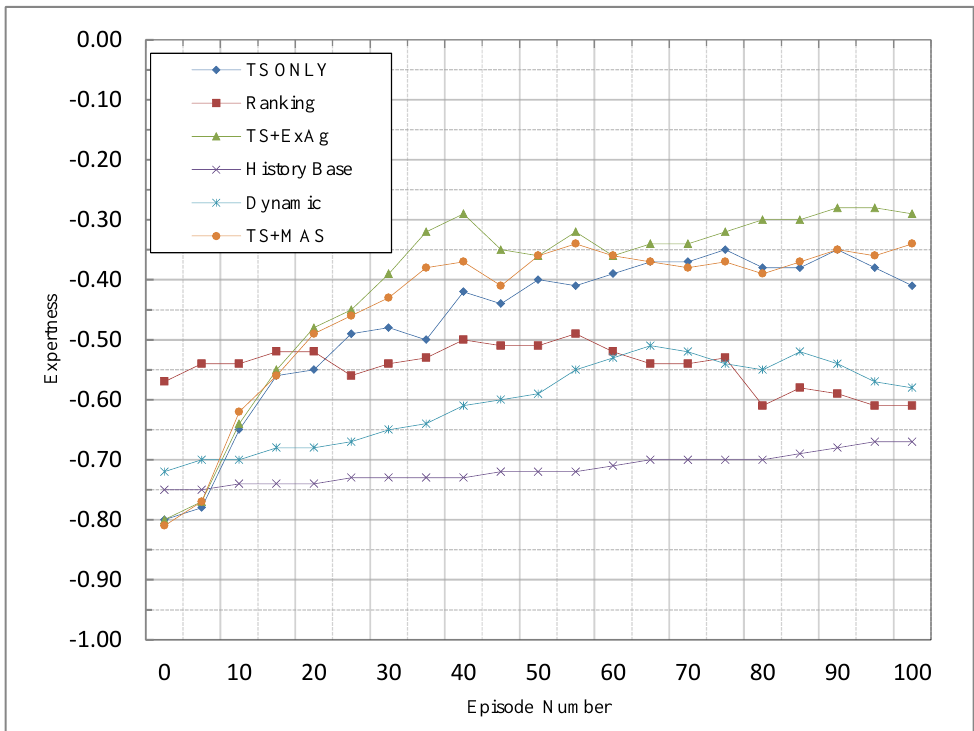
Figure 5. Comparison of MCA methods based on the expertness